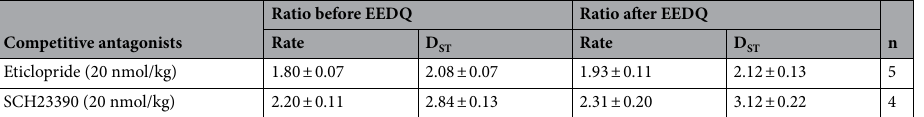
Table 1. The effect of an injection of EEDQ on the potency of eticlopride and SCH23390 to elevate the rate of cocaine self-administration and the satiety threshold (Dst). The ratio of the rate of cocaine maintained self-administration and the peak satiety threshold after injection of competitive antagonist compared to values prior to injection. Ratios were not significantly different before or after EEDQ treatment for either eticlopride or